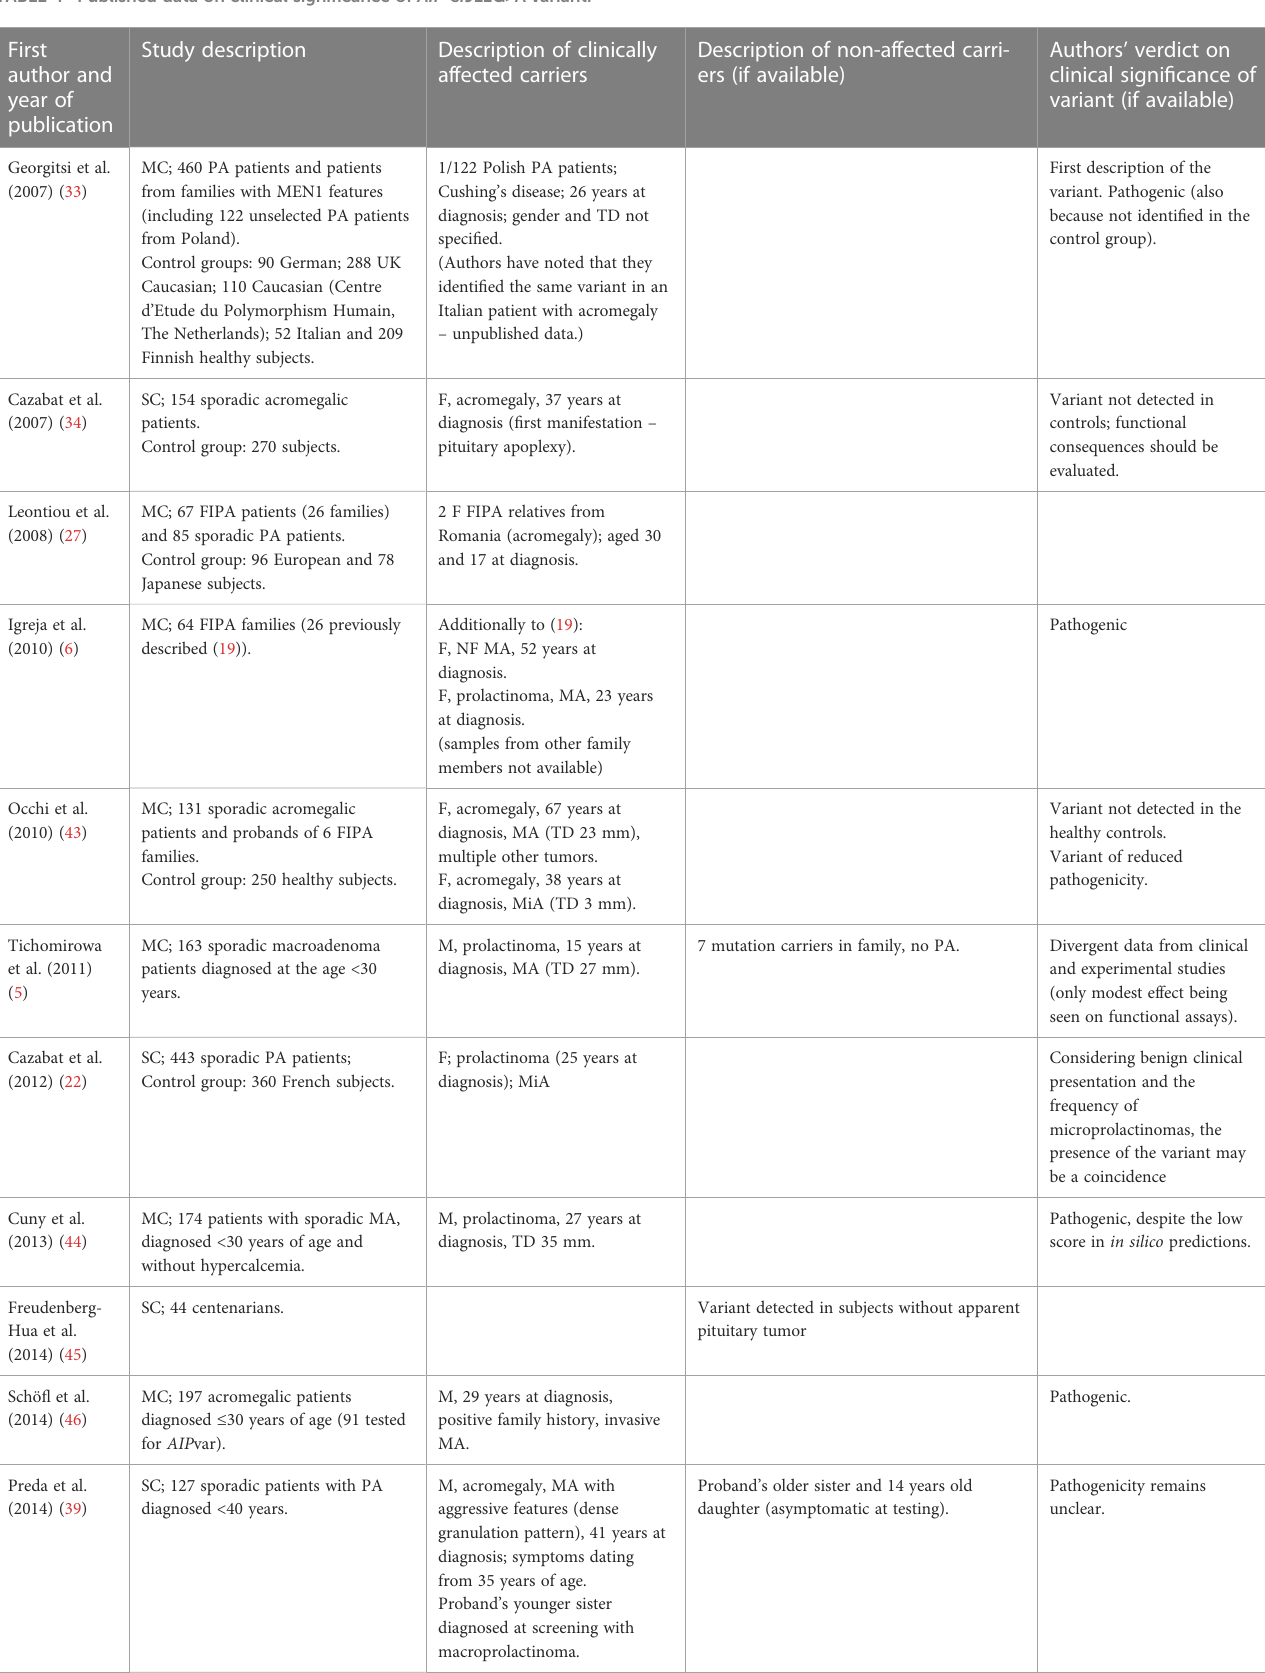
TABLE 4 Published data on clinical signi fi cance of AIP c.911G>A